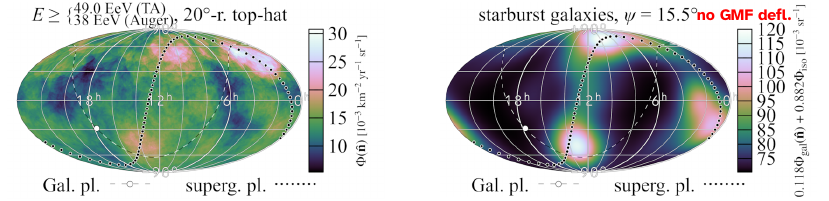
Figure 1. The observed UHECR flux above 38EeV, compared to the starburst galaxy model